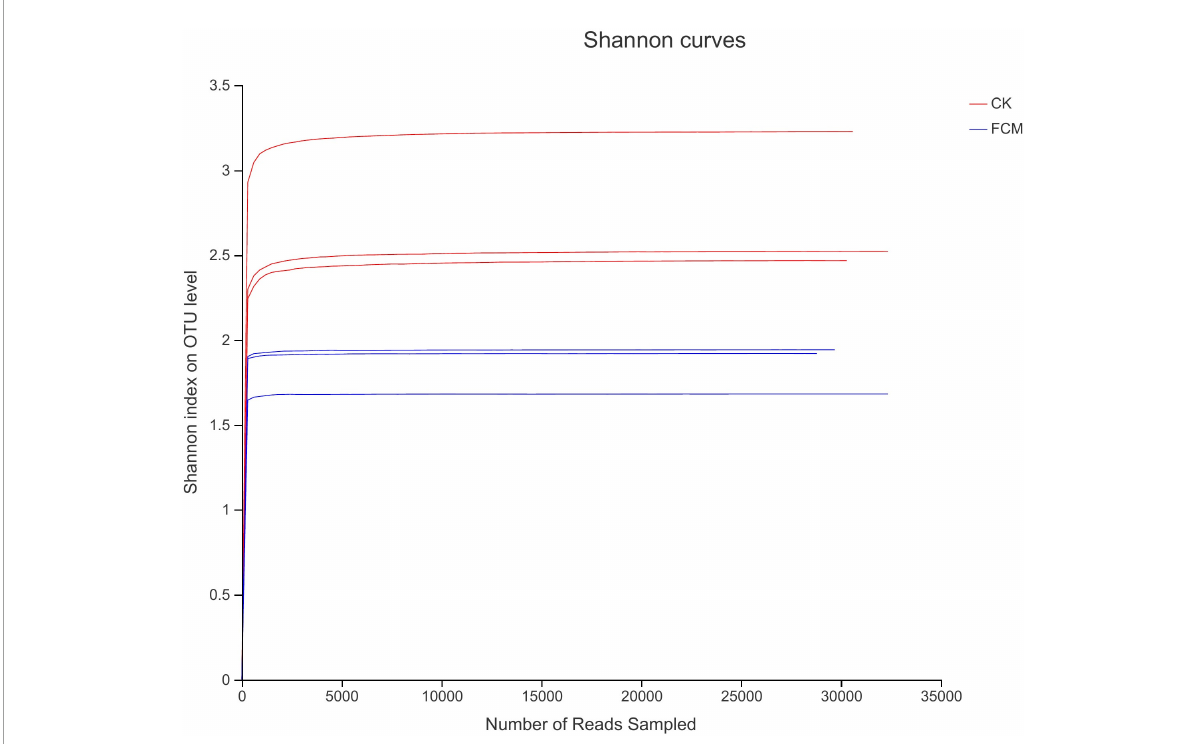
FIGURE5 Shannon curves based on OUT level [CK: cottonseed meal (CM); fermented cottonseed meal (FCM): FCM].